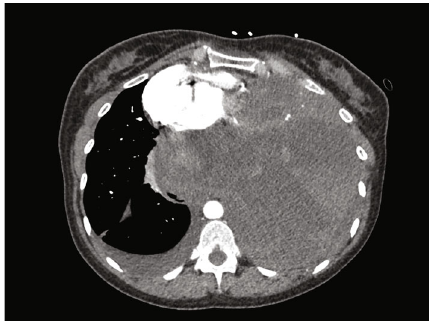
Figure 1: CT axial view arterial phase postcontrast large 17 : 9 × 17 : 6 × 18 : 3 cm heterogeneous mass centered within the left hemithorax, resulting in rightward mediastinal shift. An incidental right pleural e ff usion is present.